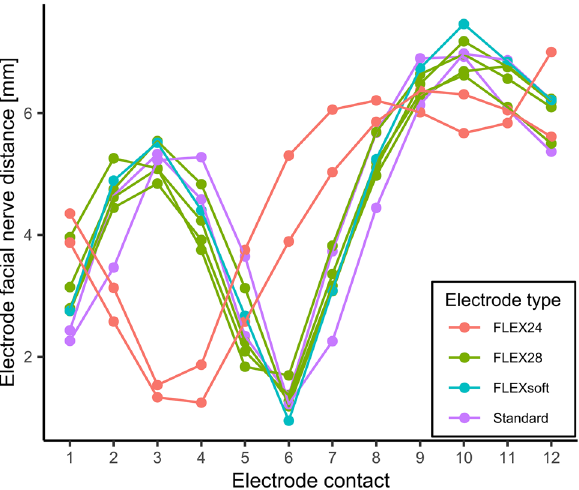
Figure 4. Electrode facial nerve distance as function of the electrode contact number. Distances were measured from fpVCT SECO scans in cochlear view. Colors correspond to different implanted electrode types.